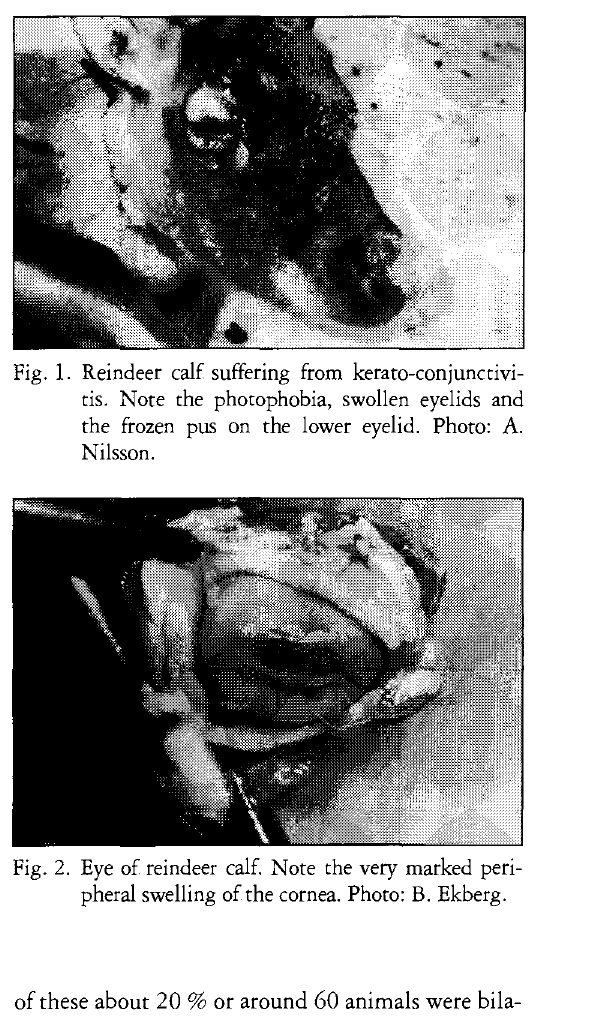
Fig. 1. Reindeer calf suffering from keratoconjunctivi tis. Note the photophobia, swollen eyelids and the frozen pus on the lower eyelid. Photo: A. Nilsson.